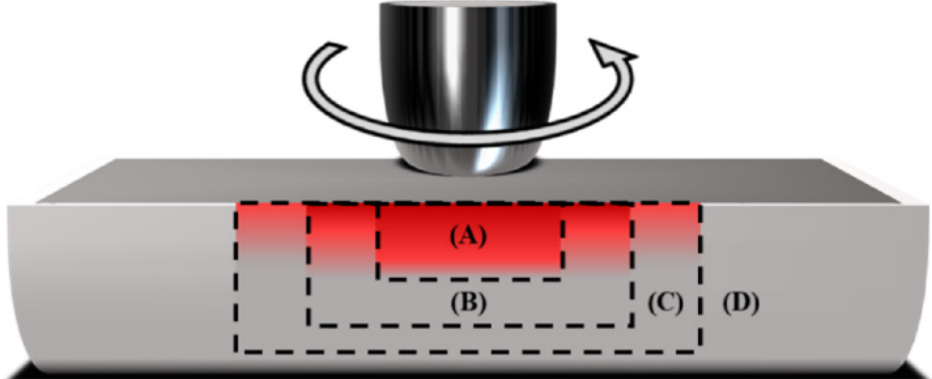
Figure 12. Various zones in the FSW process. Zone A is SZ, zone B is TMAZ, zone C is HAZ and D is BM. Reprinted with permission from reference [93]. Copyright MDPI, 2021.